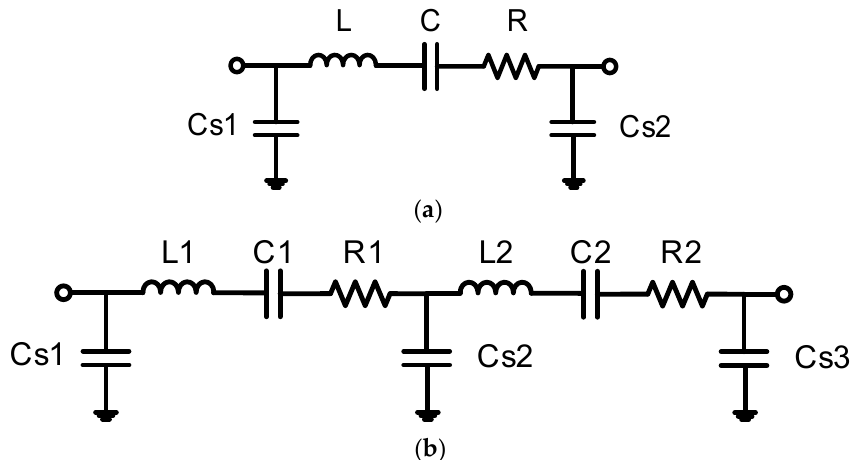
Figure 8. Lumped equivalent circuits for the microstrip interdigital capacitor. ( a ) Lower frequency; ( b ) higher frequency.